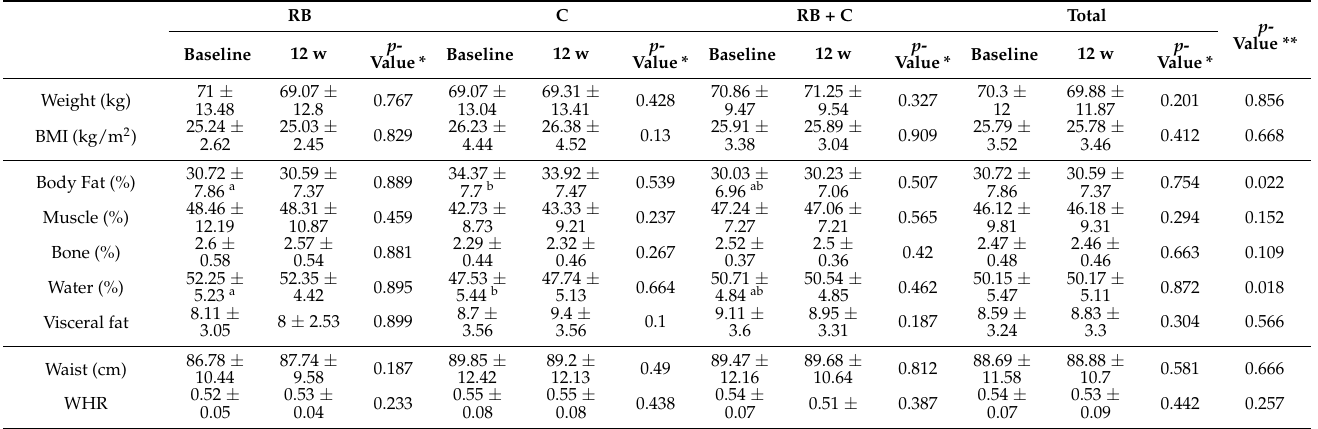
Table 4. Anthropometric parameters in each group and by visit.